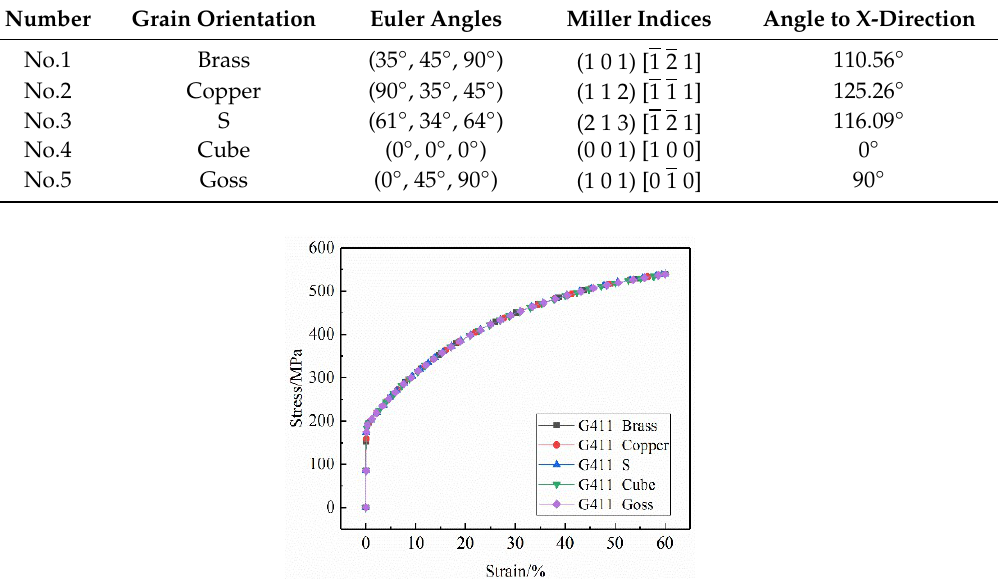
Figure 6. {111} pole figure before RVE deformation with random orientation. Table 2. Five typical grain orientations of G411.